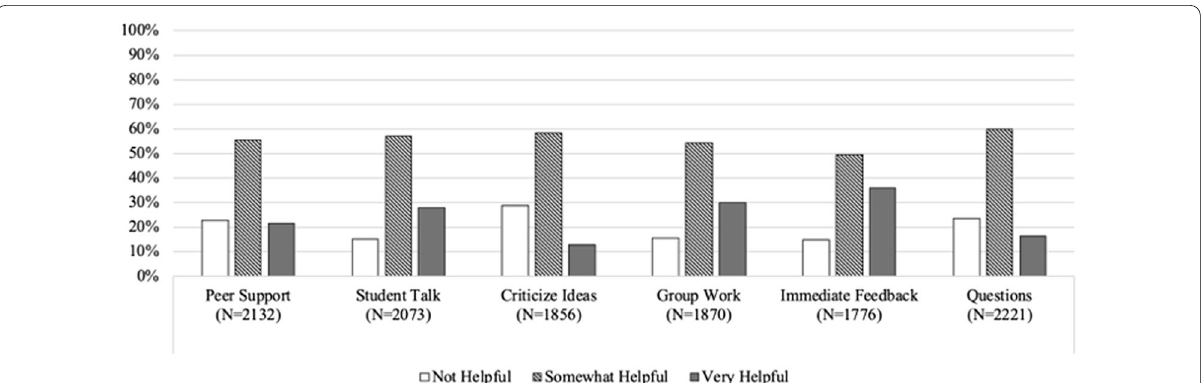
Fig. 6 Summary of helpfulness of minimally or somewhat descriptive Interactive Classroom Characteristics